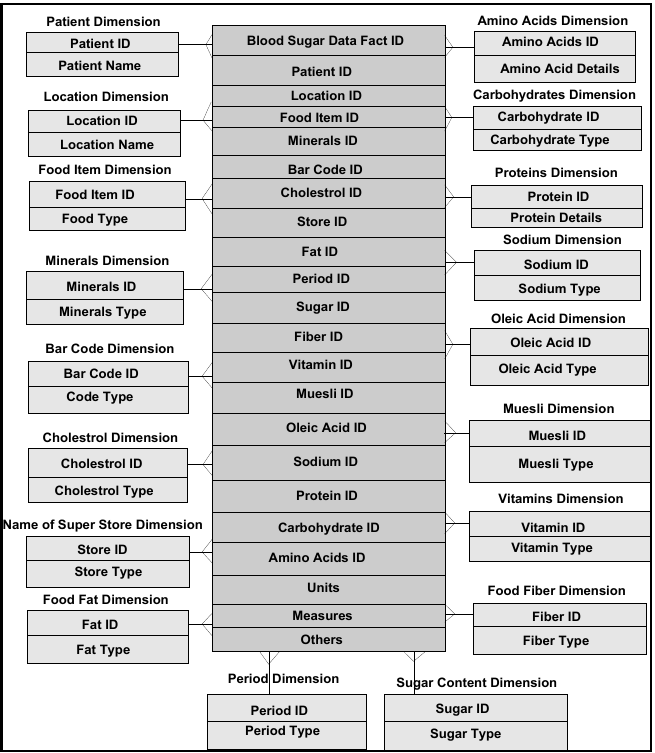
Figure 7. Multidimensional model of different qualities of foods that affect the blood sugar